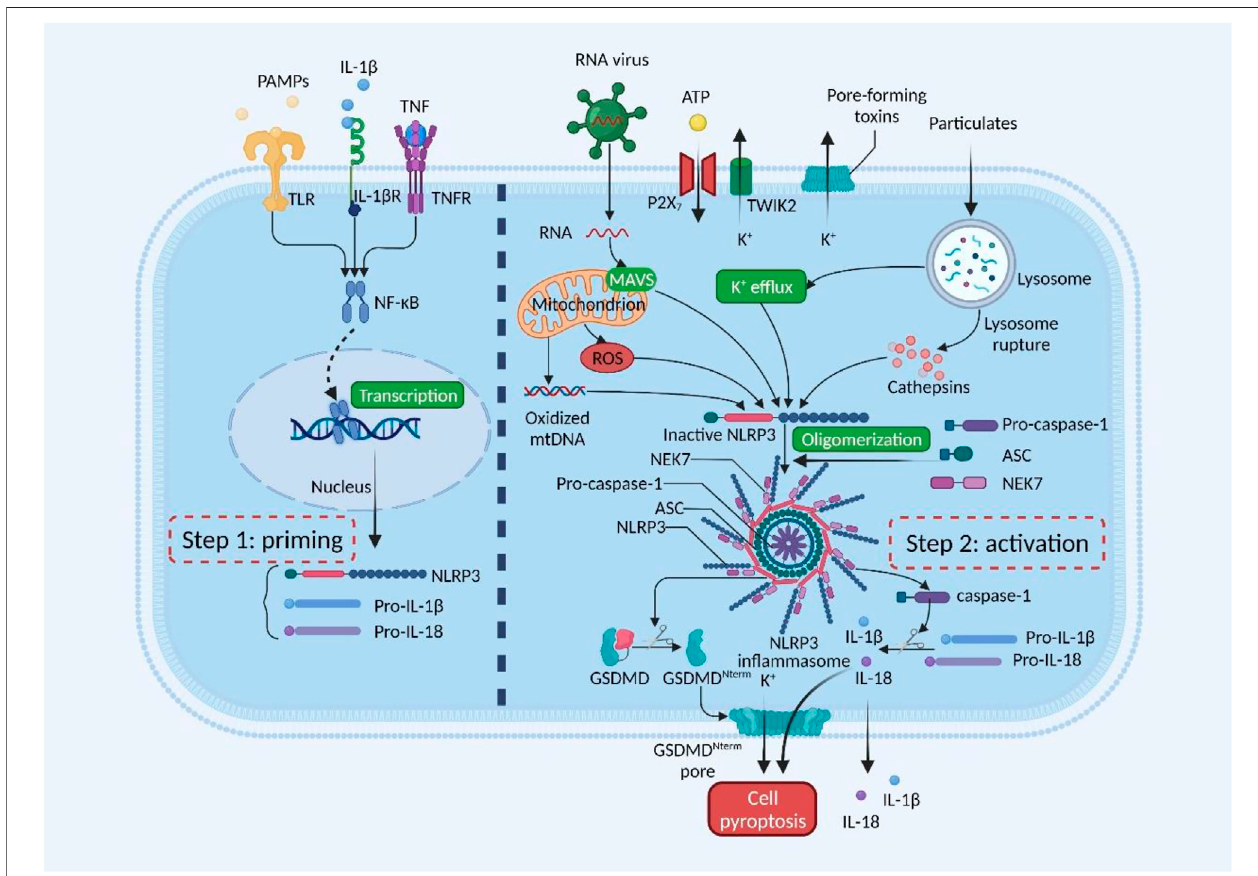
FIGURE 1 | Mechanisms of NLRP3 in fl ammasome activation. NLRP3 in fl ammasome must be primed, followed by activation. The priming step is activated by pathogen-associated molecularpatterns(PAMPs)orcytokines,leadingtotranscriptionalupregulationofNLRP3,pro-IL-1 β ,andpro-IL-18.Theactivationstepisinducedby numerous PAMPs or damage-associated molecular patterns (DAMPs), such as particulates, pore-forming toxins, and ATP. RNA viruses activate NLRP3 through mitochondrialantiviralsignalingprotein(MAVS)onthemitochondrialoutermembrane.NLRP3in fl ammasomeactivatescaspase-1,whichinturncleavespro-IL-1 β and pro-IL-18.GasderminD(GSDMD)isalsocleavedandinsertedintothemembrane,formingporesandinducingpyroptosis.GSDMDNterm,GSDMDamino-terminalcelldeath domain; NEK7, NIMA-related kinase 7; NF- κ B, nuclear factor- κ B; P2X 7 , P2X purinoceptor 7; ROS, reactive oxygen species; TLR, Toll-like receptor; TNF, tumor necrosis factor; TNFR, tumor necrosis factor receptor; TWIK2, two-pore domain weak inwardly rectifying K+ channel 2. This fi gure was created with